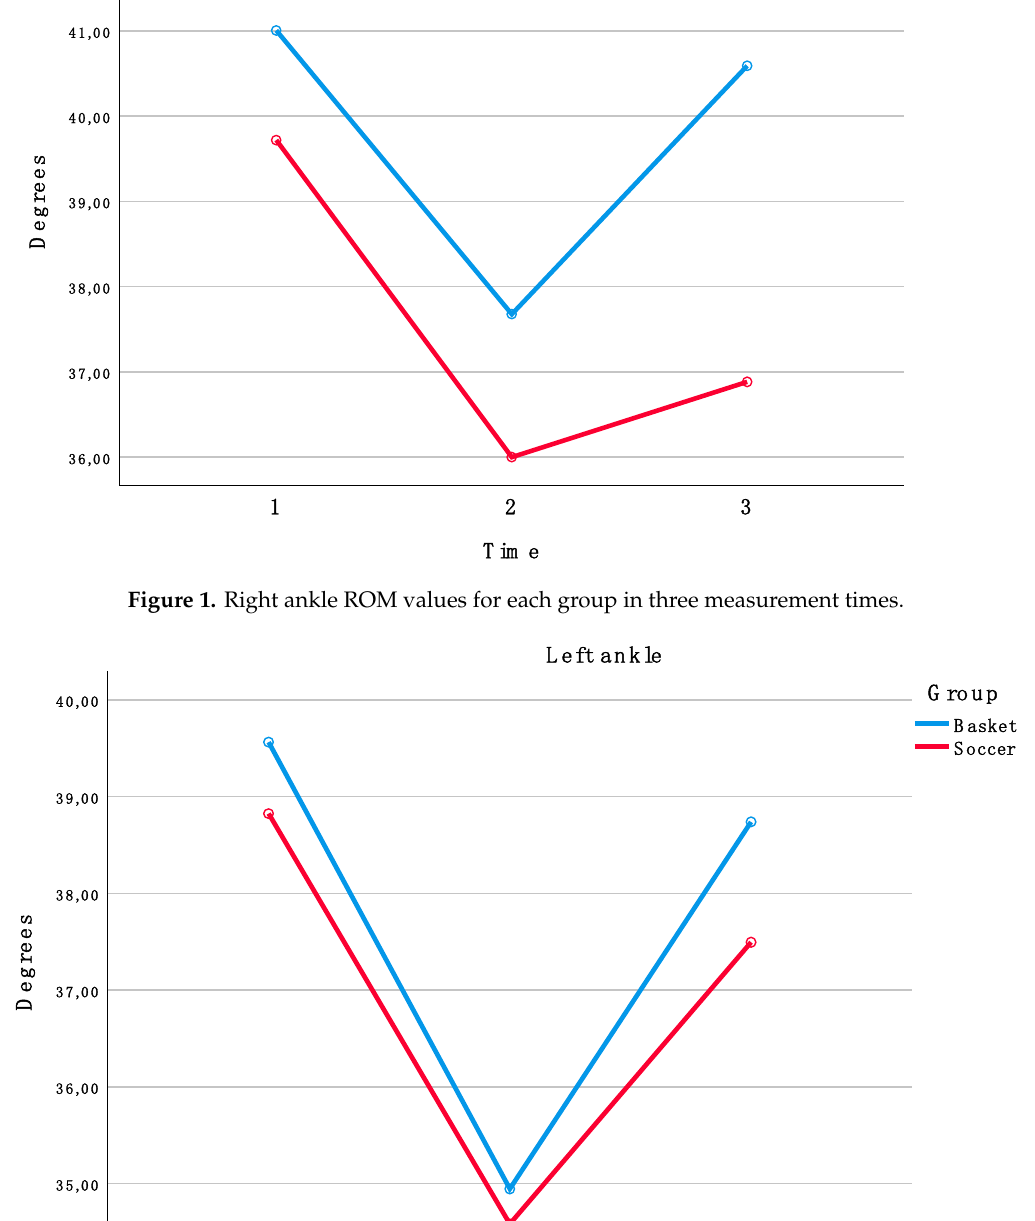
Figure 2. Left ankle ROM values for each group in three measurement